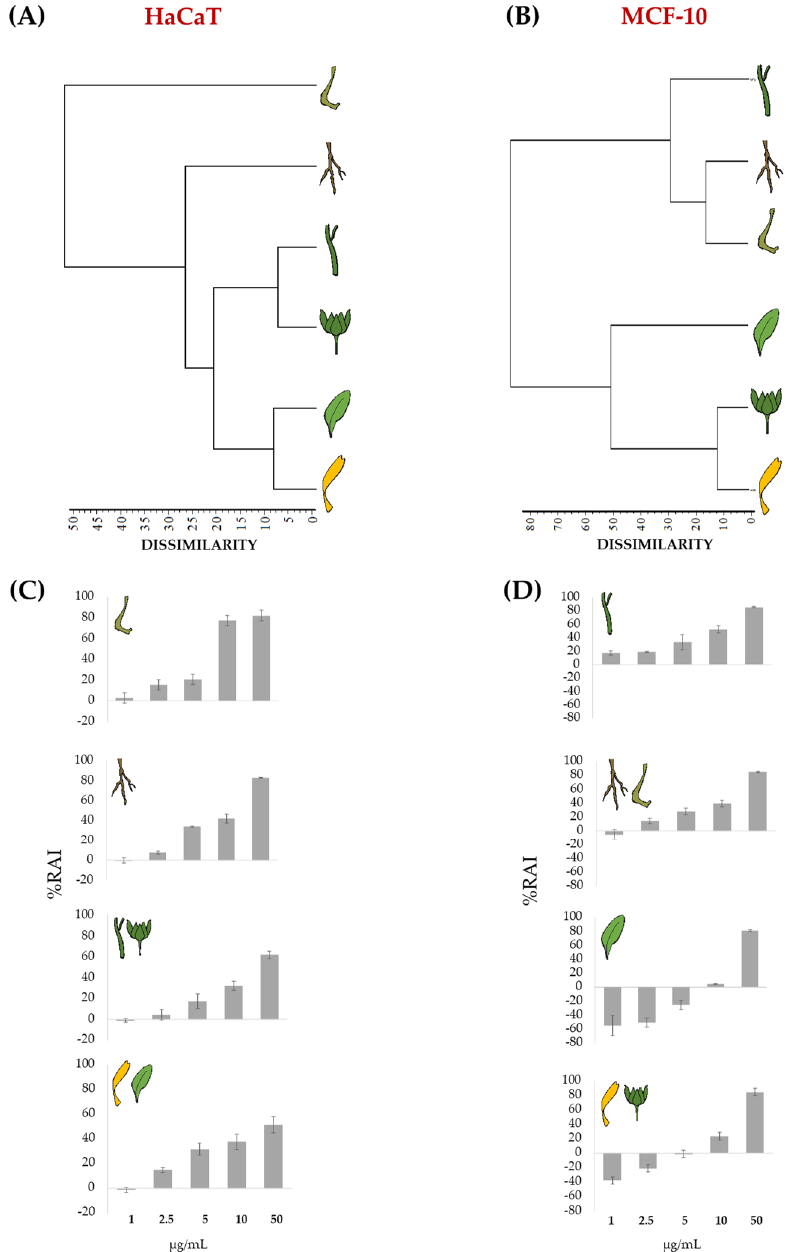
Figure 6. Dendrograms of cytotoxic activity (MTT assay) of apolar extracts of the different organs of Calendula arvensis on HaCaT ( A ) and MCF-10 ( B ) cell lines. Redox activity inhibition (%RAI) values of HaCaT ( C ) and MCF-10 ( D ) are ordered as clustered in the dendrograms. Data are expressed as means ± SD of the experiment performed in three replicates.